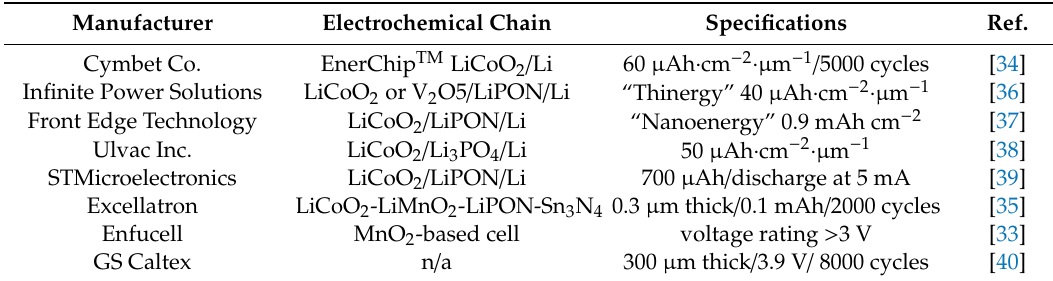
Table 2. Industrial developments of thin film microbatteries.